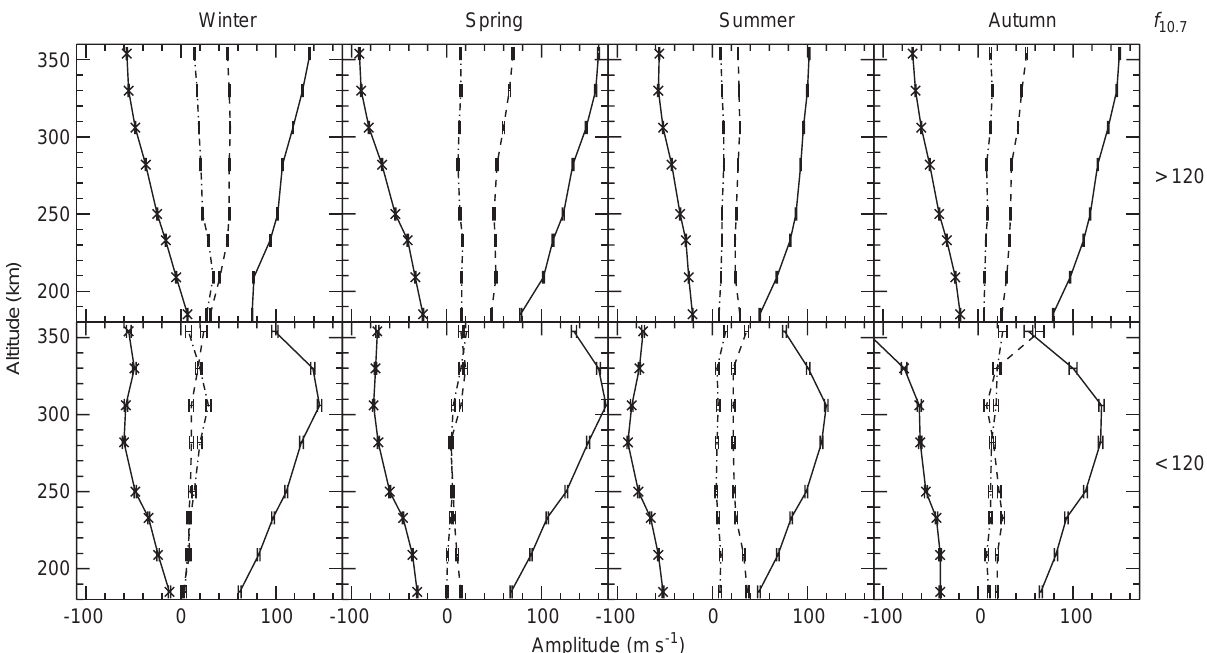
Fig. 5. Height amplitude profiles: mean wind ( solid line plus crosses ), A included